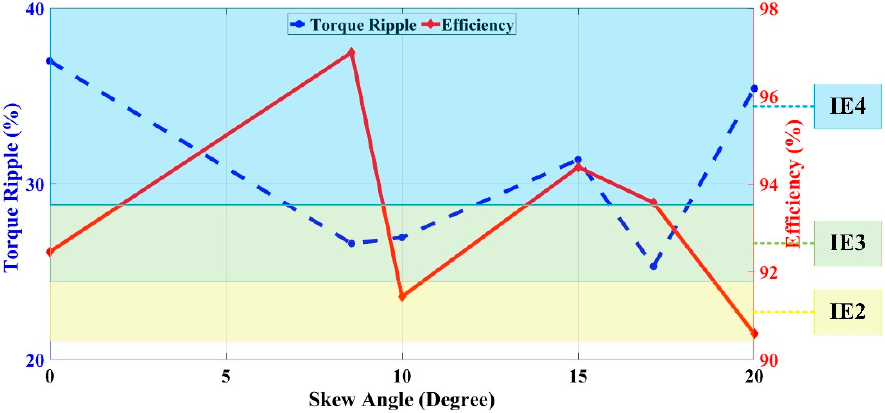
Figure 12. Efficiency and torque results of AFIM with 42 slots. Figure 12. E ffi ciency and torque results of AFIM with 42